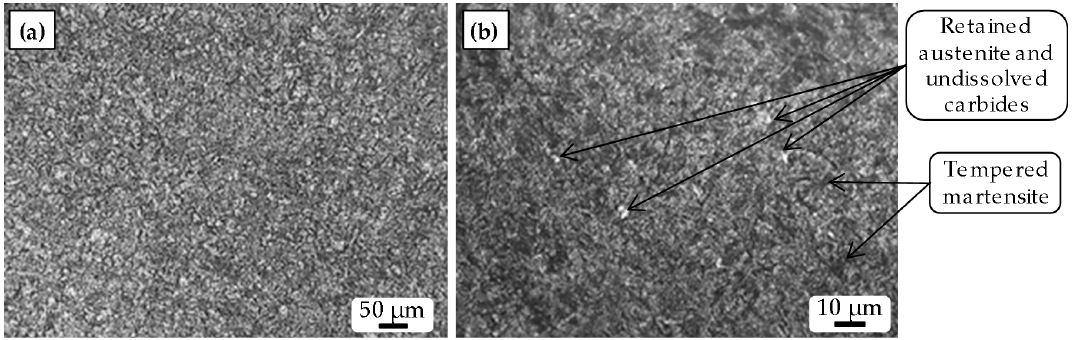
Figure 6. Microstructure of ( a ) the substrate; ( b ) the deposited material.